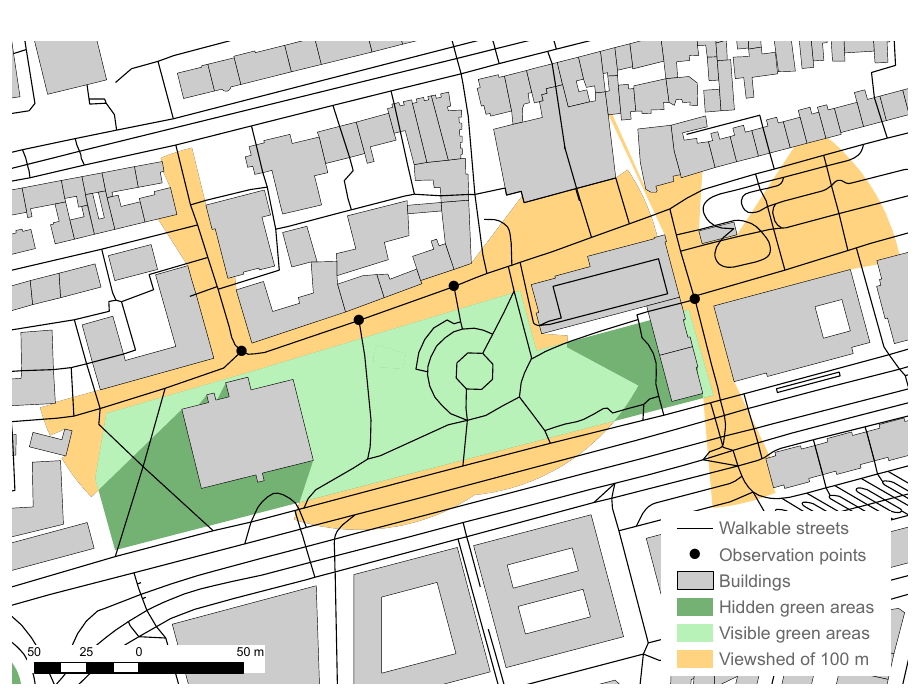
Figure 3. Example of the visible green areas inside the viewsheds of the 100 m radius from the four observation